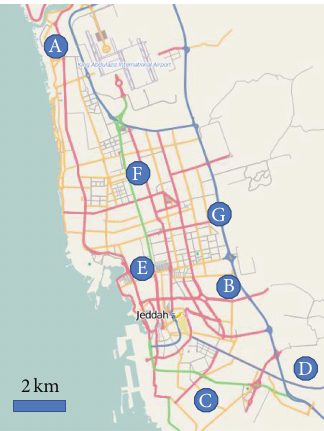
Figure 1: Sampling sites and their relative locations on the map of Jeddah